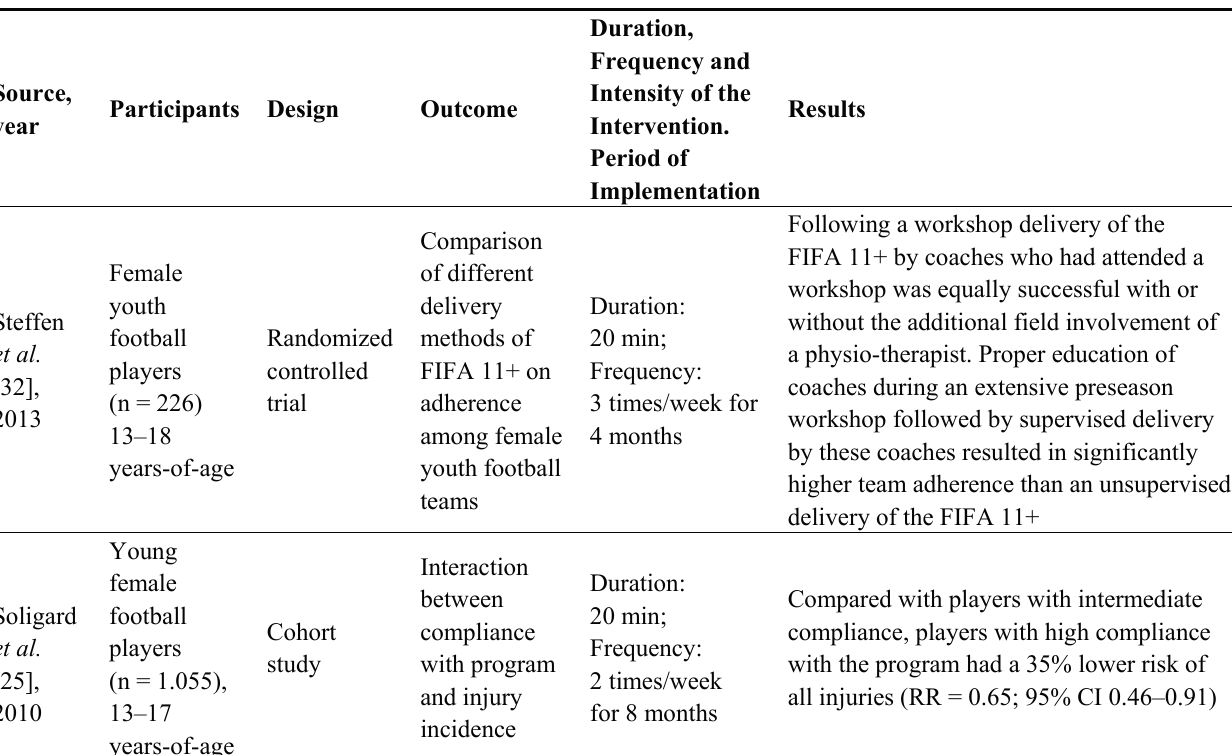
Table 4. Summary of studies that assessed the cost effectiveness of the FIFA 11+, compliance with the program or different delivery methods, according to year, country, design, outcome measures and